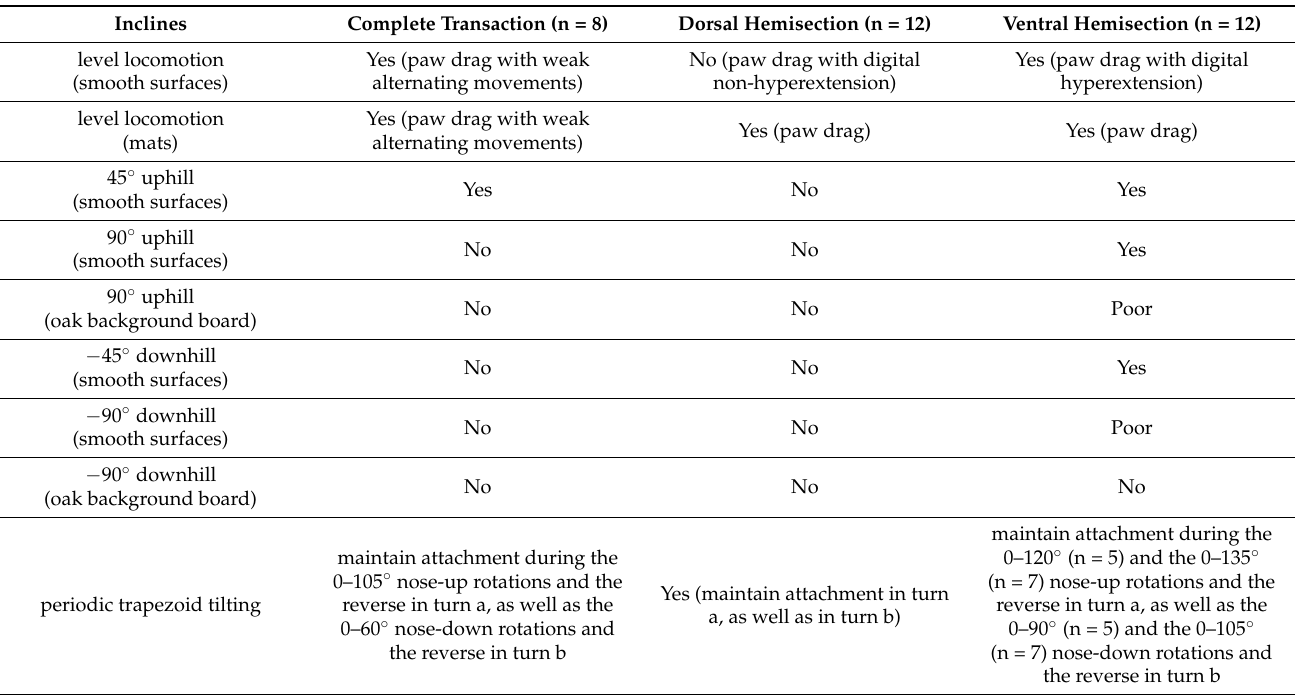
Table 2. Comparison of persistent adhesion locomotor deficits in the geckos after chronic partial or complete spinal cord